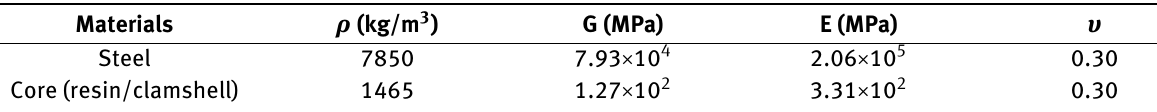
Figure 2: Reference existing model of existing stiffened car deck Table 2: Mechanical